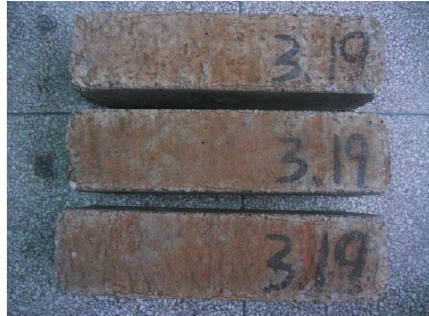
Figure 3: Appearance damage of specimens N10G1R45 after 90 cycles of drying-wetting.